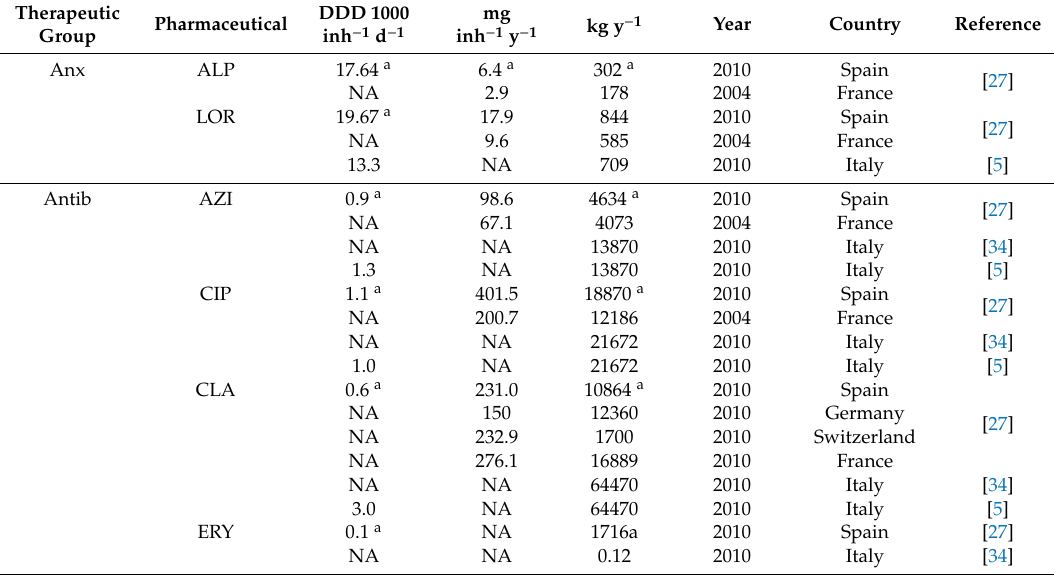
Table 2. International consumption of the selected